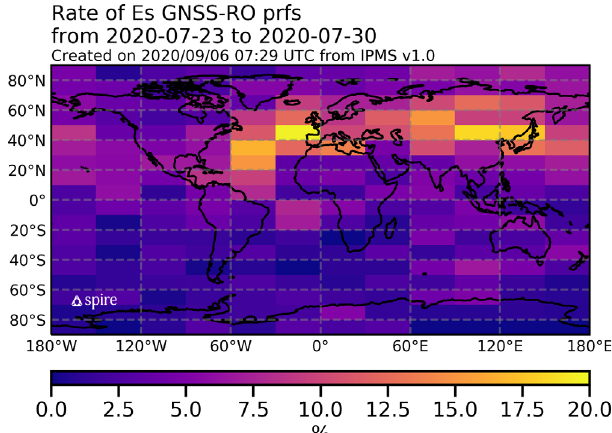
Fig. 13. Relative density of Es from Spire pro fi les to total number of pro fi les gathered globally from 2020/07/23 to 2020/07/30. The Es perturbations are picked up at fairly high rates at mid-latitude in the northern hemisphere (summertime), consistent with sporadic E climatological